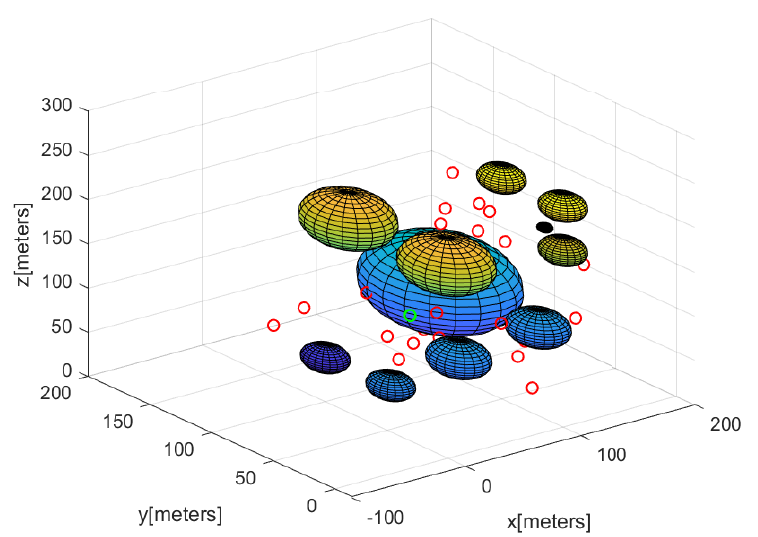
Figure 11. Every UUV’s final position (green circles) after the rendezvous is completed (the discard approach is utilized). A total of 25 broken UUVs are illustrated with red circles. Obstacles are plotted with